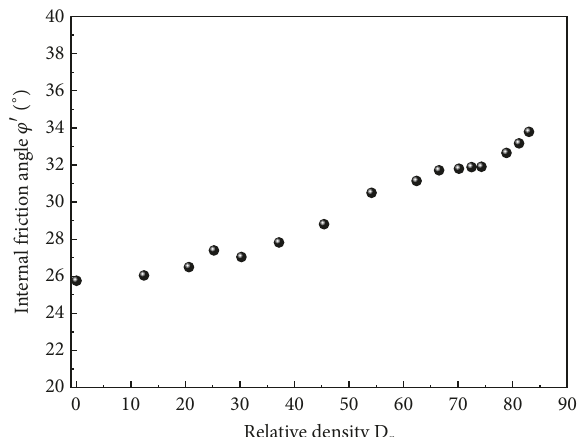
Figure 9: Internalfriction angles of different relative density at peak state.